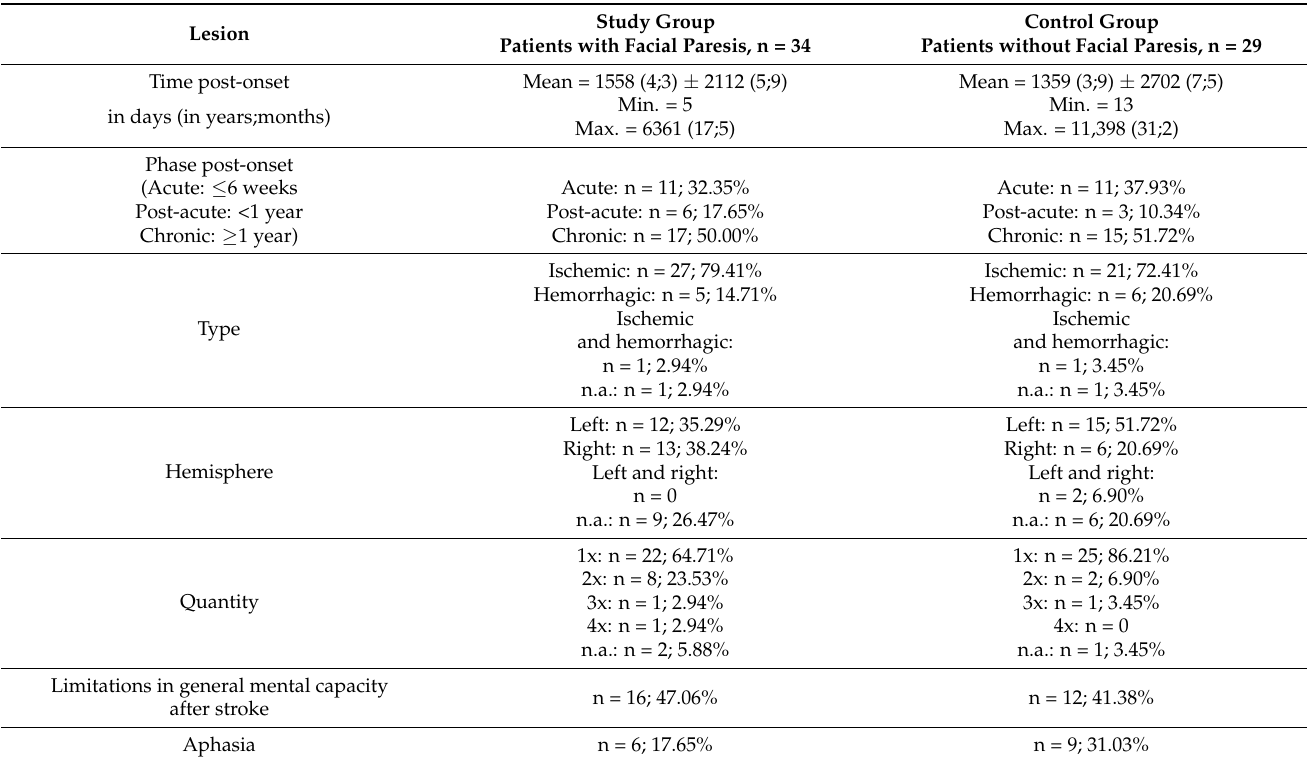
Table A2. Lesion information, times post-onset of the examinations in this study, type of lesion (ischaemic, hemorrhagic or both), affected hemisphere, quantity (number of lesions), limitations in general mental capacity after stroke and aphasia.